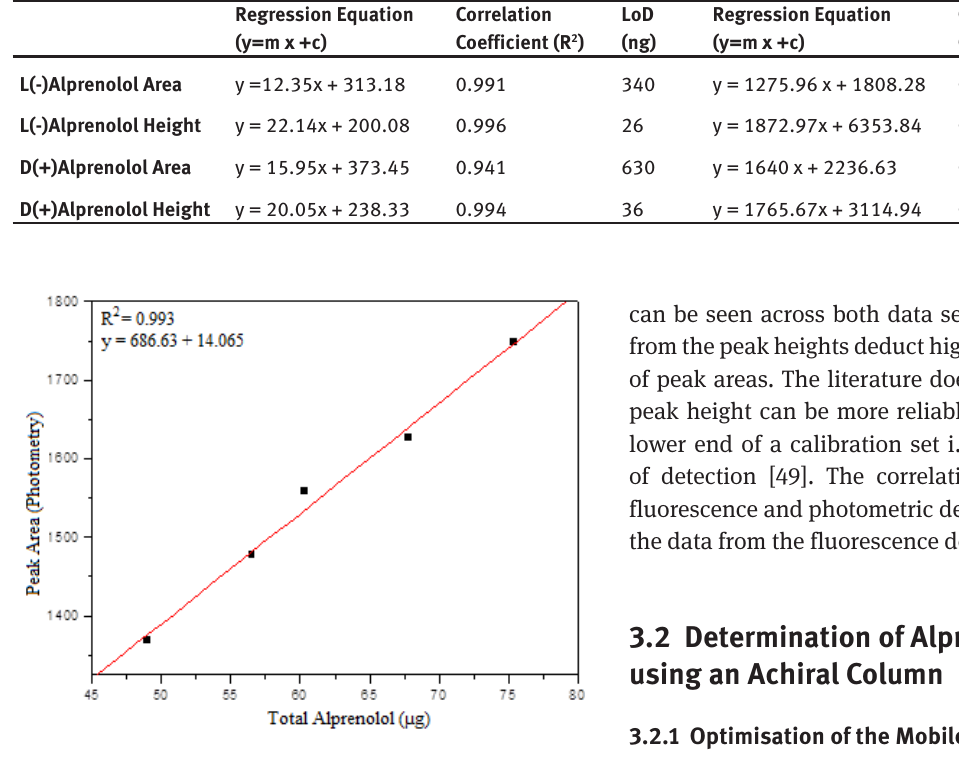
Figure 3: Photometry calibration plot using peak area as a function of the total (±)-Alprenolol in each calibration standard (µg).